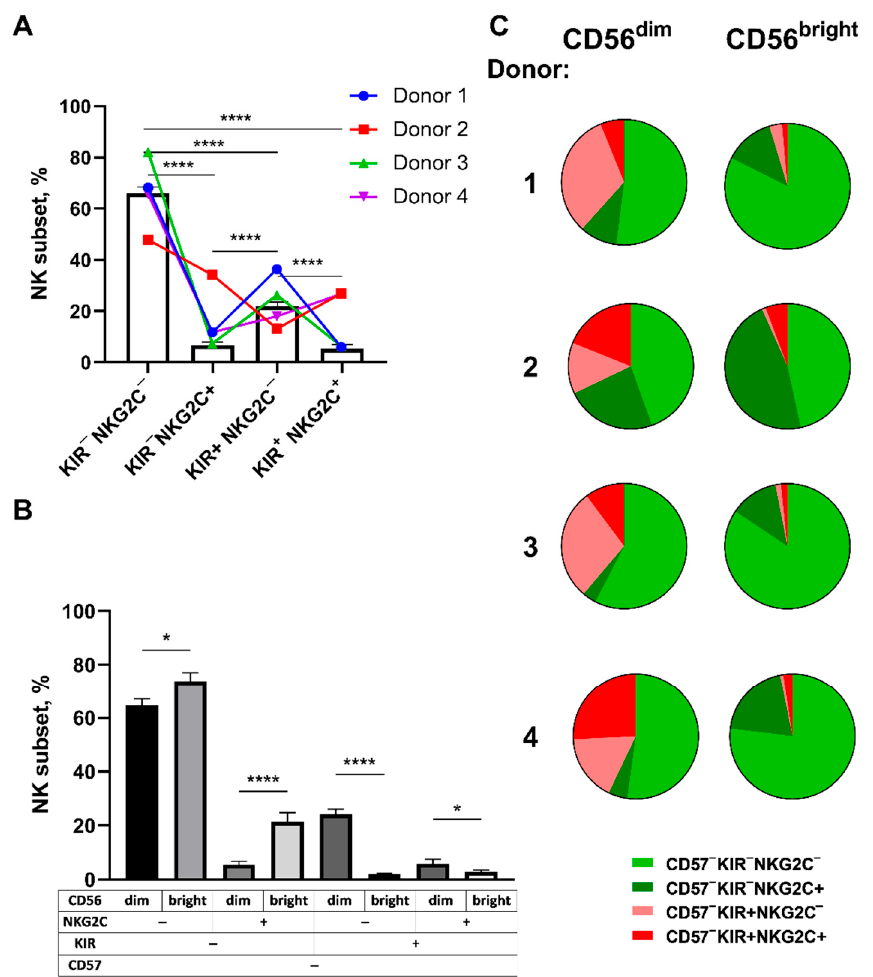
Figure 2. Comparison of ex vivo proportions of the CD57 − KIR2DL2/3 +/ − NKG2C +/ − NK cell subsets in HCMV + healthy donors. ( A ) Proportions of the KIR2DL2/3 +/ − NKG2C +/ − subsets in CD57-negative NK cells from different donors, n = 16 (bars, means ± SE). The four donors selected for transduction experiments are highlighted with colors and lines. ( B ) The averaged KIR2DL2/3 +/ − NKG2C +/ − NK cell proportions in the CD56 dim CD57 − and CD56 bright CD57 − subpopulations, n = 16 (means ± SE). ( C ) The proportions of CD57 − KIR2DL2/3 +/ − NKG2C +/ − NK cells in the CD56 dim and CD56 bright subpopulations for each of the four individual donors selected for transduction experiments. Statistical analysis was performed using a paired t -test (* p < 0.05; **** p < 0.0001).